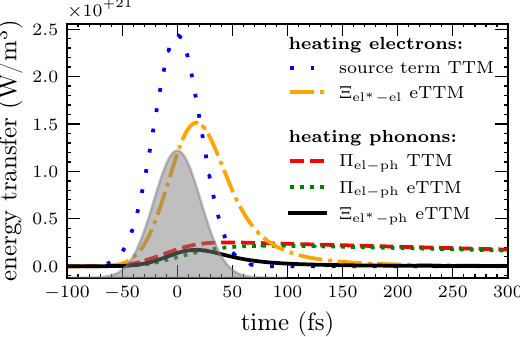
Figure 3. Dynamics of the rate of energy transfer in dependence of time, comparing a TTM and eTTM simulation. The notation corresponds to the definitions introduced in Equation (2). The source term of the TTM, i.e., the laser power density s ( t ) , is shown in the blue loosely dotted line. In the eTTM, the increase in electronic temperature is mediated by interaction with non-equilibrium electrons, described by Ξ el*–el and shown with a yellow dashed-dotted line. It lasts considerably longer than the direct laser heating of the TTM. The heating of the phonons is described in the TTM with the electron–phonon coupling term, here denoted as Π el–ph and depicted with a red dashed line. It is rather similar to the energy transfer from equilibrium electrons to phonons in the eTTM, described by the same term, Π el–ph , and depicted with a green dotted line. Only the initial heating of phonons by equilibrium electrons is slightly reduced. This is due to the lower temperature of electrons in the eTTM; compare Figure 2a. However, the non-equilibrium electrons provide an additional heating mechanism of the phonons in the eTTM, denoted as Ξ el*–ph and depicted with a black solid